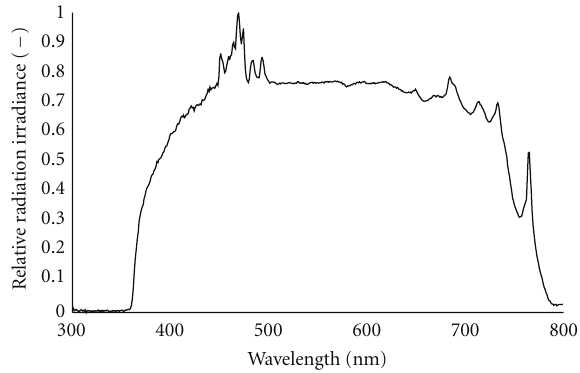
Figure 3: Emission spectrum of a 150 W xenon